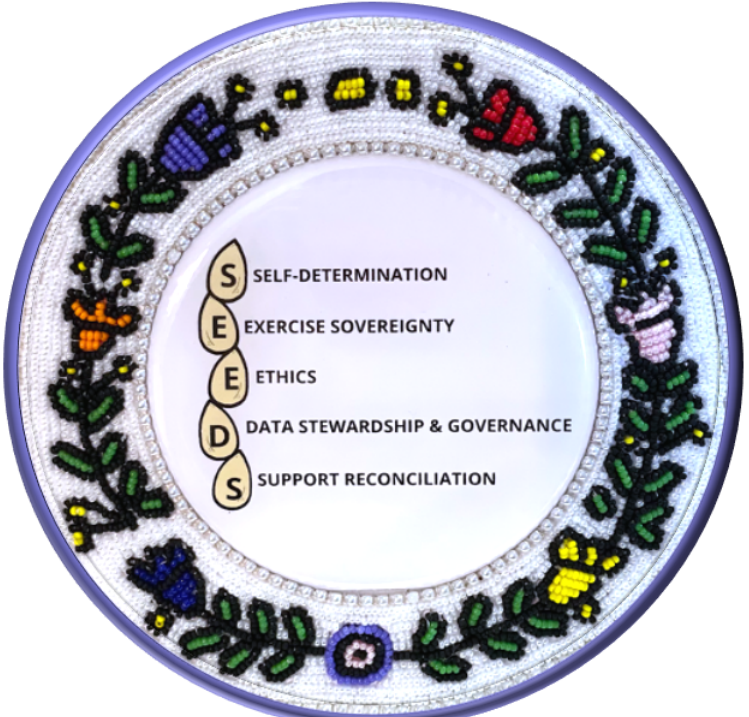
Figure 1: The SEEDS Principles for Indigenous Population Health Data